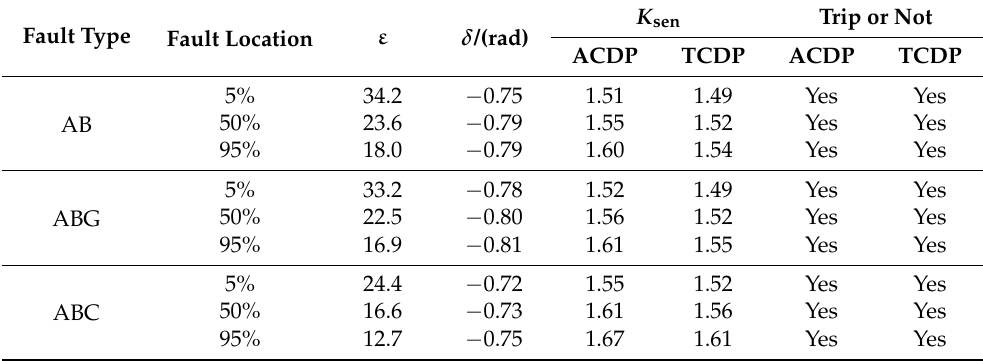
Table 8. Simulation results of DG 4 out of operation during metallic multi-phase faults occur at feeder B 7 B 8